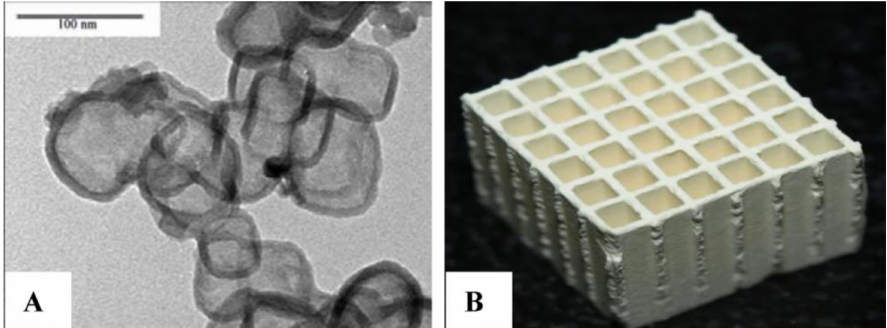
Figure 9. Porous hollow silica NPs ( A ) and monolithic cordierite ( B ) (reproduced with permission from [253]. Copyright 2013, Elsevier